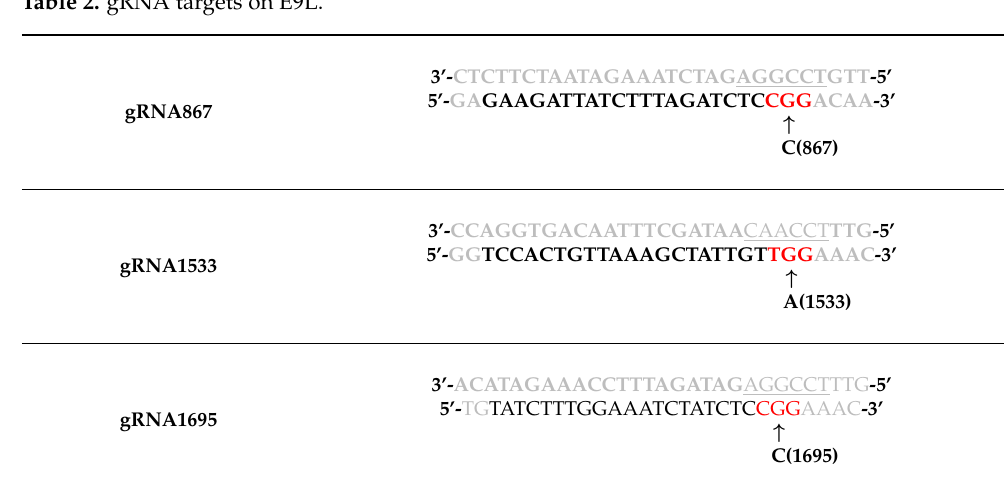
Table 2. gRNA targets on